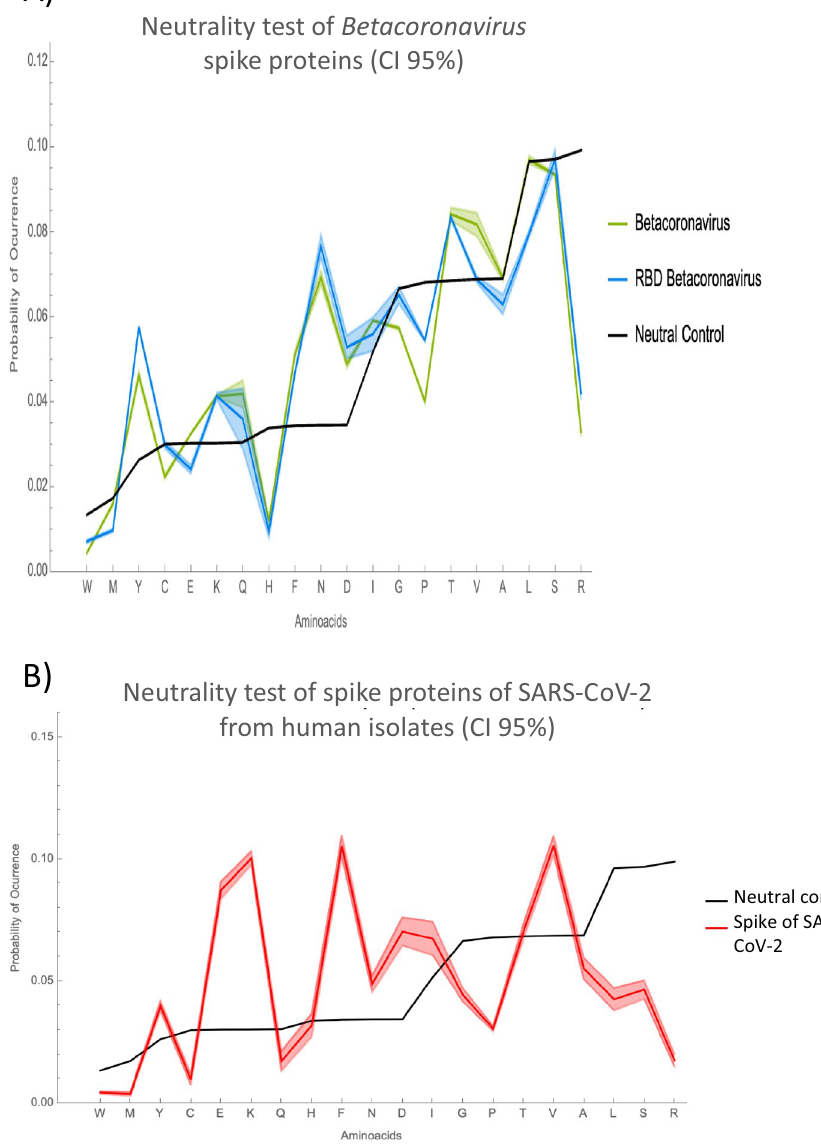
Figure 1. Neutral evolution test of the a.a. of the spike protein and the RBD. The probability of occurrence of each a.a. in a hypothetical protein that has nonselective pressures over its mutations (black line), compared to ( A ) the probability of occurrence for a.a. of the spike protein of Betacoronavirus (green) and of the a.a. of the RBD (blue). ( B ) the neutrality test to the spike protein of SARS-CoV-2 from human isolates (red). A.a. with higher occurrence than that predicted by purely stochastic changes are under positive selection pressure, while frequencies lower than the neutral prediction are amino acids that underwent negative selection pressures. A Jackknife procedure was performed to obtain confidence interval of 95%. All calculations were made with Wolfram Mathematica